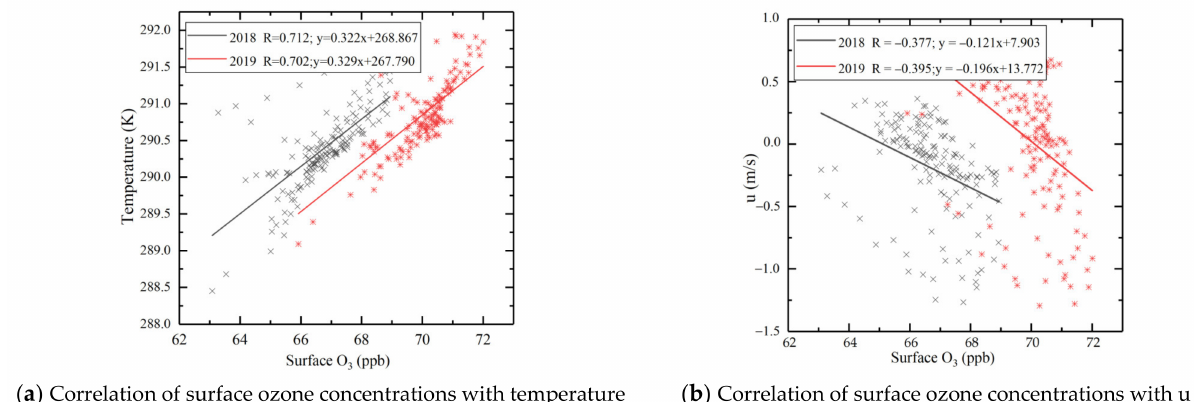
Figure 16. Correlation of surface ozone concentrations with temperature ( a ) and u ( b ) in southern NCP (36 ◦ –38 ◦ N, 114 ◦ –118 ◦ E) from 2018 to 2019.